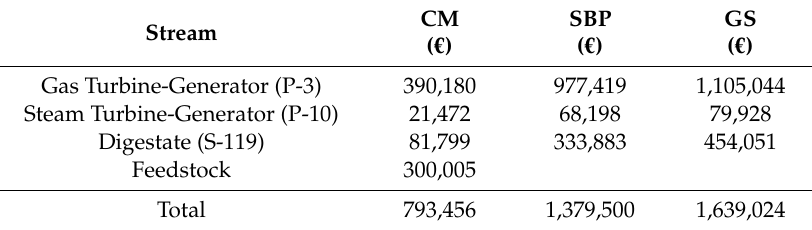
Table 13. Revenues ( € ) per year of a biogas power plant excluding subsidy.